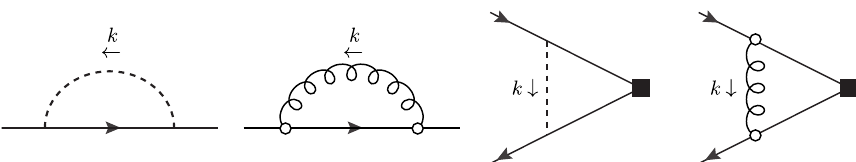
Figure 7 . Feynman diagrams for one-loop corrections to the NRQCD LDMEs. Solid lines are heavy quarks and antiquarks, dashed lines are temporal gluons, and curly lines are transverse gluons. Open circles represent insertions of the p · A vertex, and filled squares represent the operator χ † (cid:15) · σ ψ for spin triplet, and χ † ψ for spin